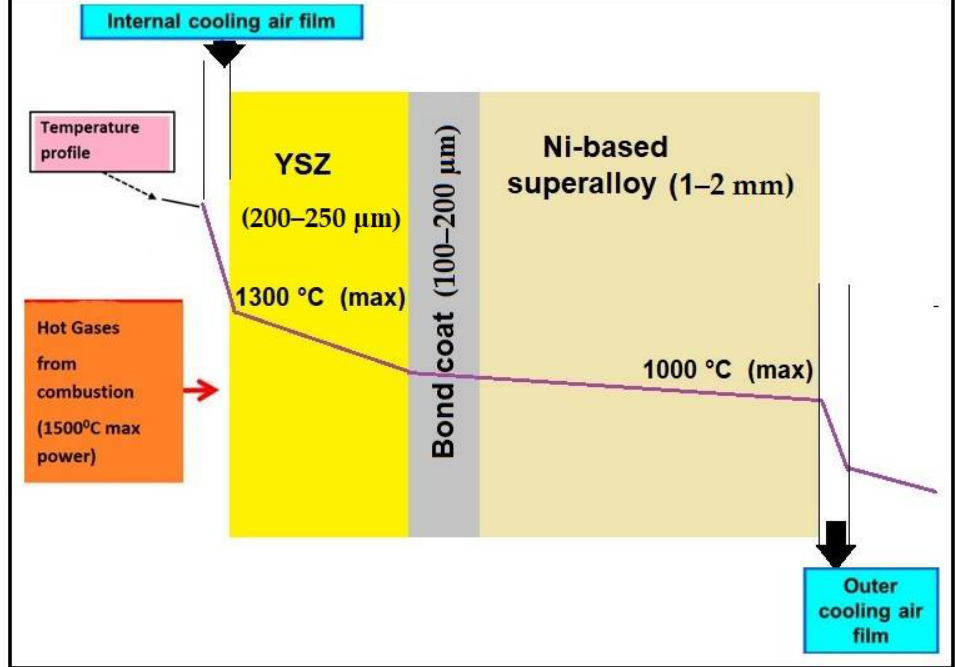
Figure 3. Schematic of the Thermal Barrier coating (TBC) part in thermal gradient and air–cooling .